Question: Which kind of chart has been used to present this data?
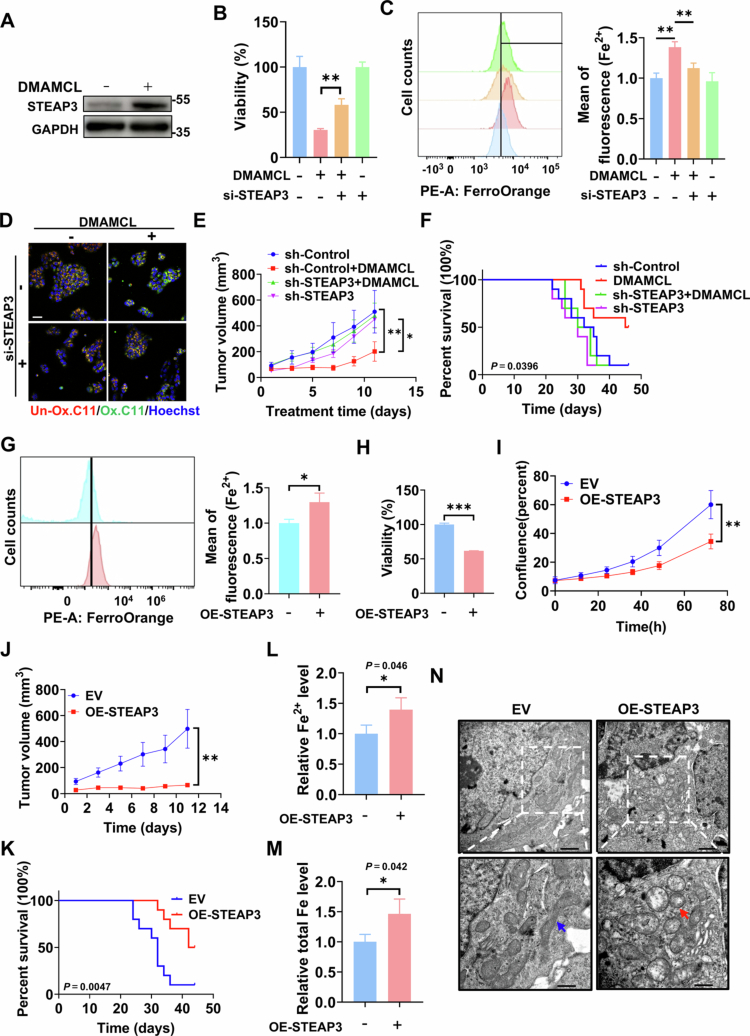
Answer: survival